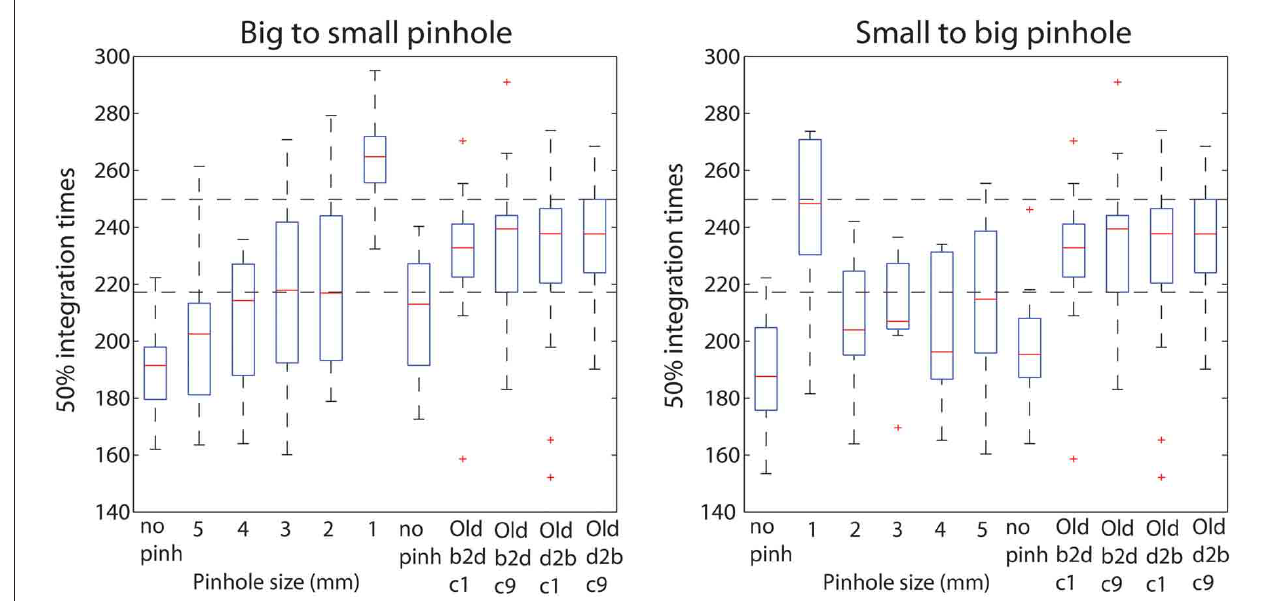
experiment (60.8cd/m 2 —c1 and c9), for the b2d and d2b sessions. Horizontal dashed lines indicate the lowest 25th and the highest 75th quantile across the old subjects’ four conditions.